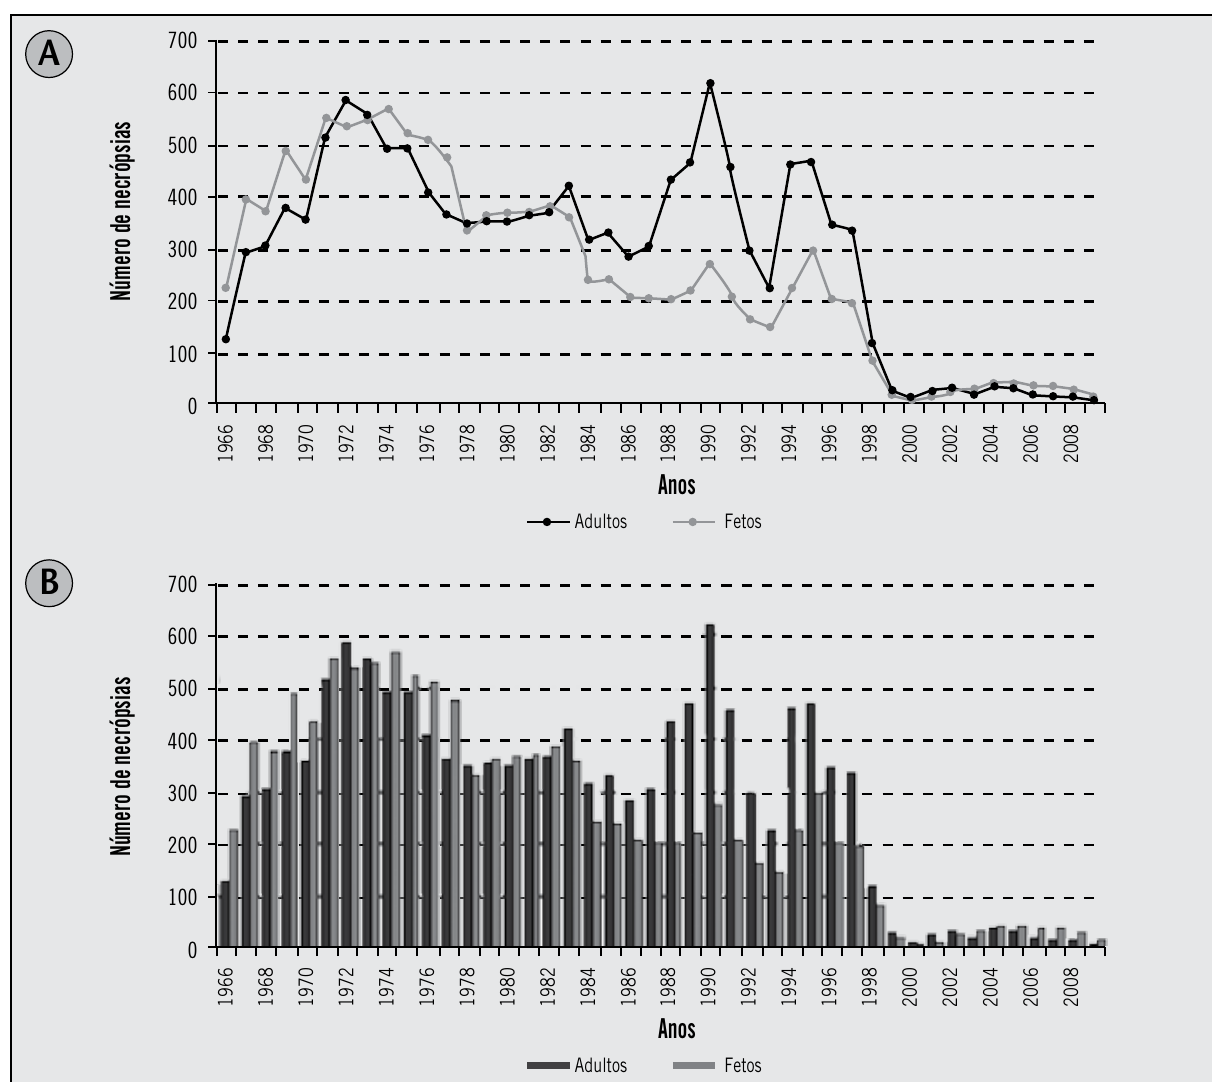
Figura – Número de necrópsias de adultos e fetos realizadas no Serviço de Anatomia Patológica do HUAP/UFF entre os anos 1966 e 2009 (A) Gráfico; (B)